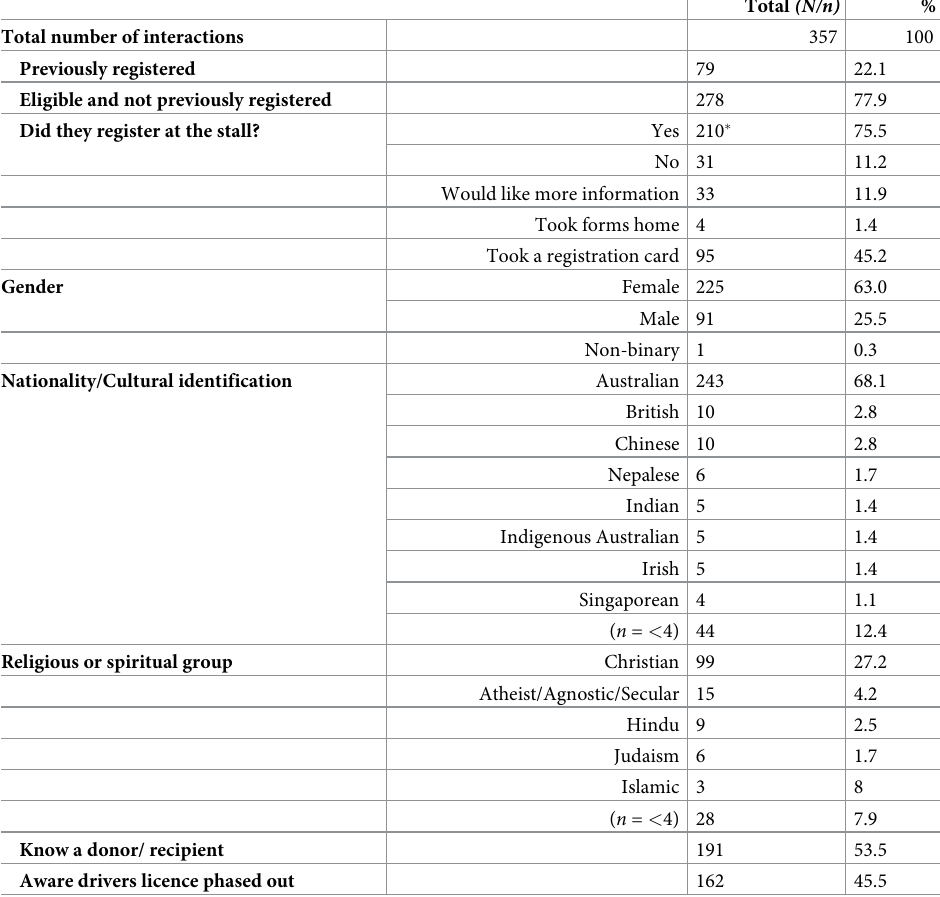
Table 1. Participant demographics and